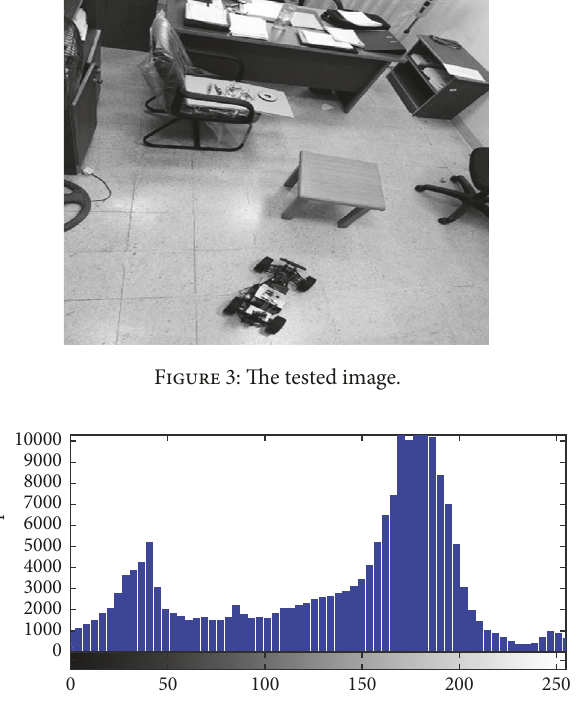
Figure 4: The histogram associated with the tested image.